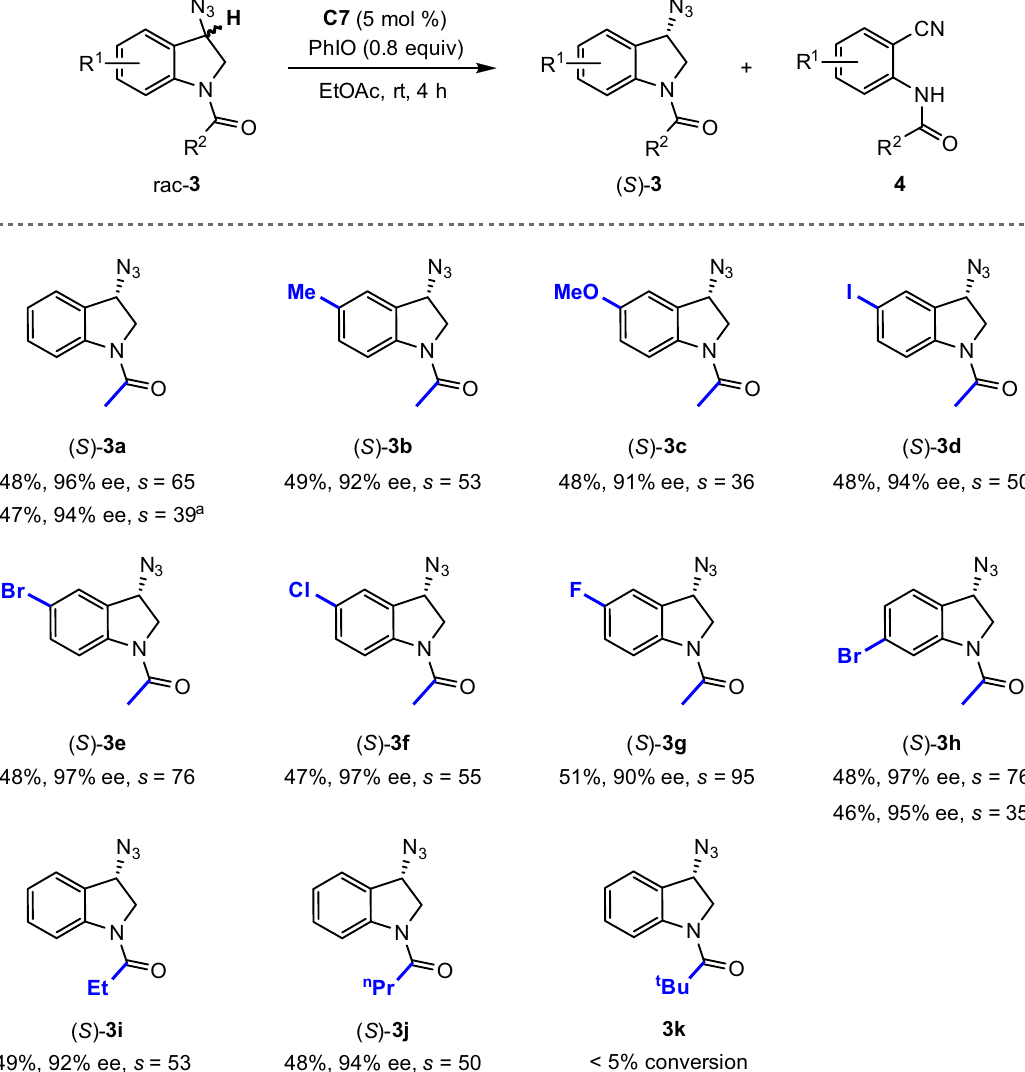
Fig. 3 Kinetic resolution of indoline-based organic azides. Conditions: rac- 3 (0.1 mmol), PhIO (0.08 mmol, addition as 8 portions in 30-min intervals over 3.5 h), and C7 (5 mol%) in ethyl acetate (1.0 ml) at rt for 4 h. a Reaction with 0.5 mmol rac- 3